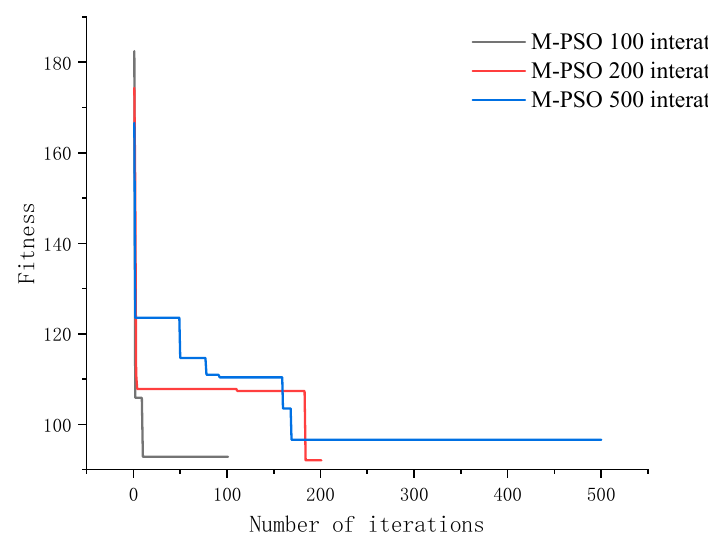
Figure 5. Fitness of M-PSO algorithm.